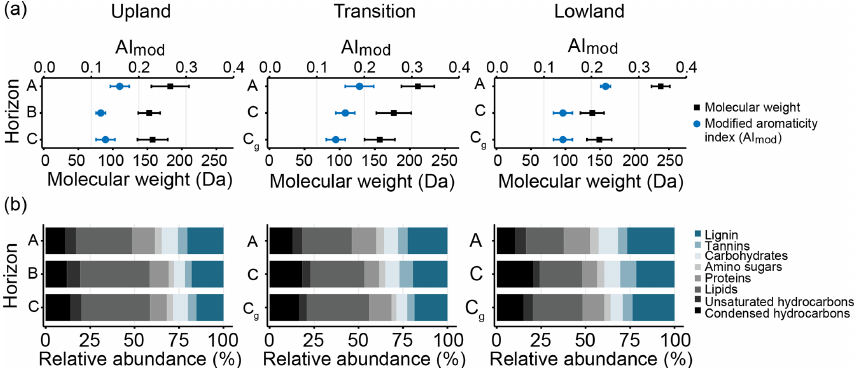
Figure 6. FT-ICR-MS analysis of water-extractable OM chemistry across upland–lowland transects. (a) Average relative abundances of compound classes as identified by O / C and H / C ratios in Van Krevelen plots. Grey-scale colors denote primarily plant-derived compound classes, while blue-scale compounds denote microbial-derived compound classes. (b) Average AI mod values, as an index for aromaticity, and molecular weights of all detected compounds. Averages represent the mean of replicate samples from six upland–lowland transects; bars are standard error of the